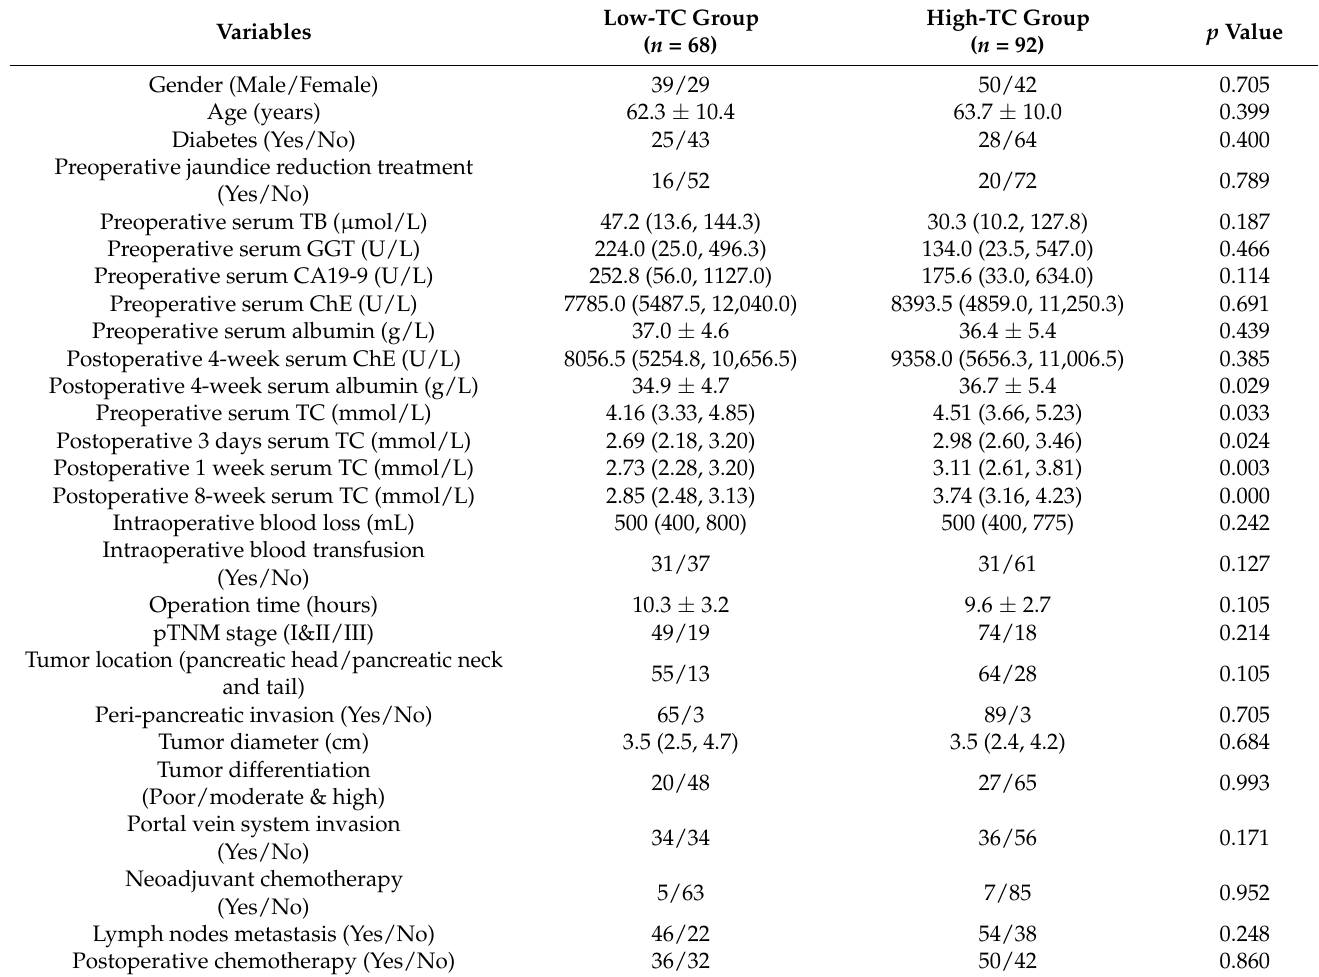
Table 3. Comparison of perioperative general data between low-TC group and high-TC